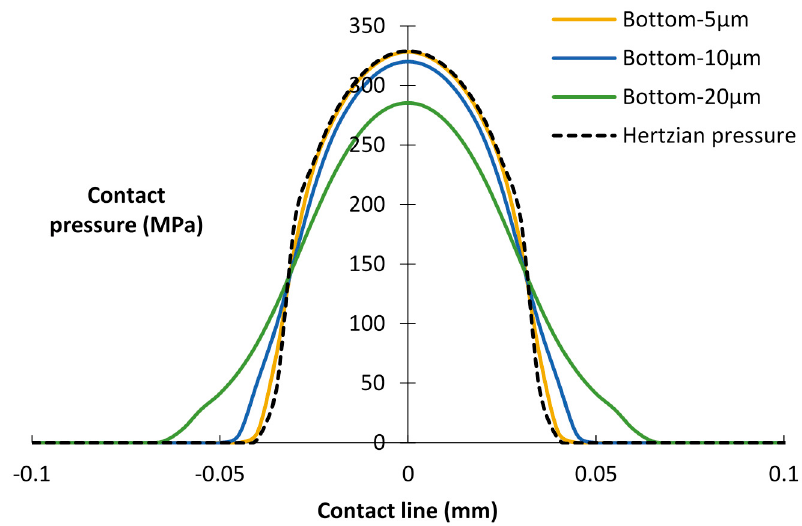
Figure 7. Contact pressure distributions of the bottom interface for different thicknesses of the debris layer, E = 360 GPa.